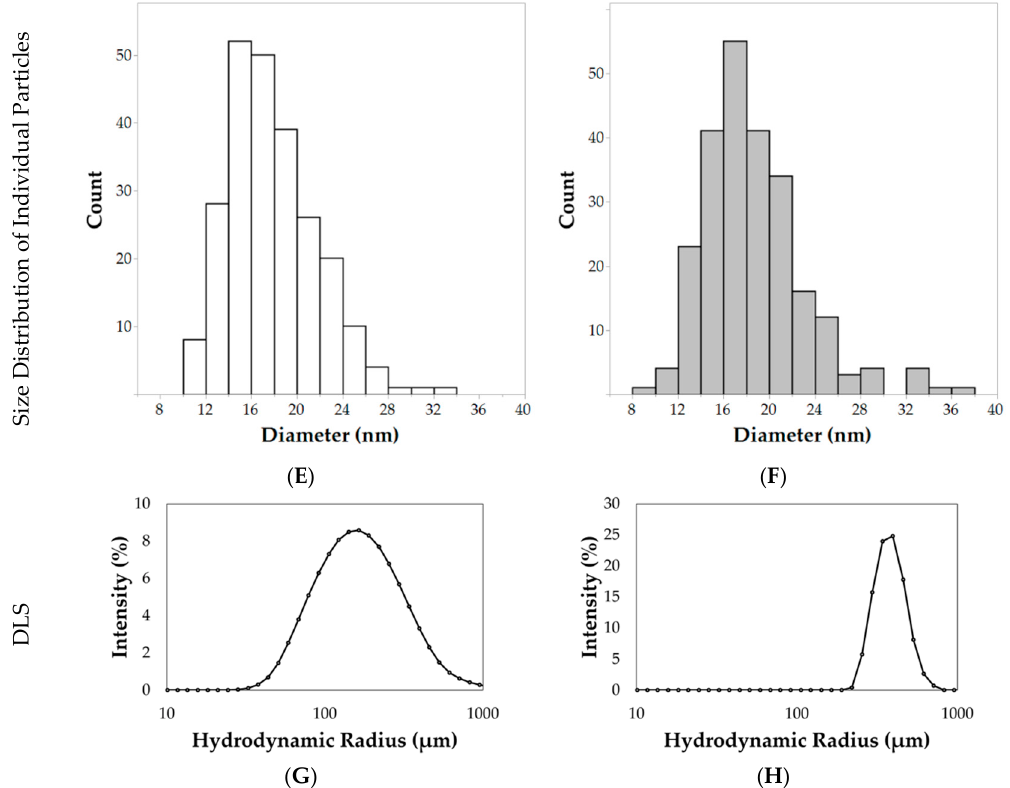
Figure 4. Electron microscopy images and size distribution histograms for the synthesized iron oxide nanoparticles. SEM images of ( A ) hydrophilic and ( B ) hydrophobic nanoparticles agglomerations 35,000 × with a scale bar of 1 µ m. TEM images show agglomerated (left, 30,000 × , scale bar = 200 nm) and individual (right, 100,000 × , scale bar = 50 nm) ( C ) hydrophilic and ( D ) hydrophobic nanoparticles. Agglomerated nanoparticles are observed if the sample is not sonicated. After sonication, the majority of nanoparticles are dispersed. A statistically significant difference was observed in the size distributions of individual ( E ) hydrophilic and ( F ) hydrophobic nanoparticles. Dynamic light scattering (DLS) results show the aggregation states of ( G ) hydrophilic and ( H ) hydrophobic nanoparticles.